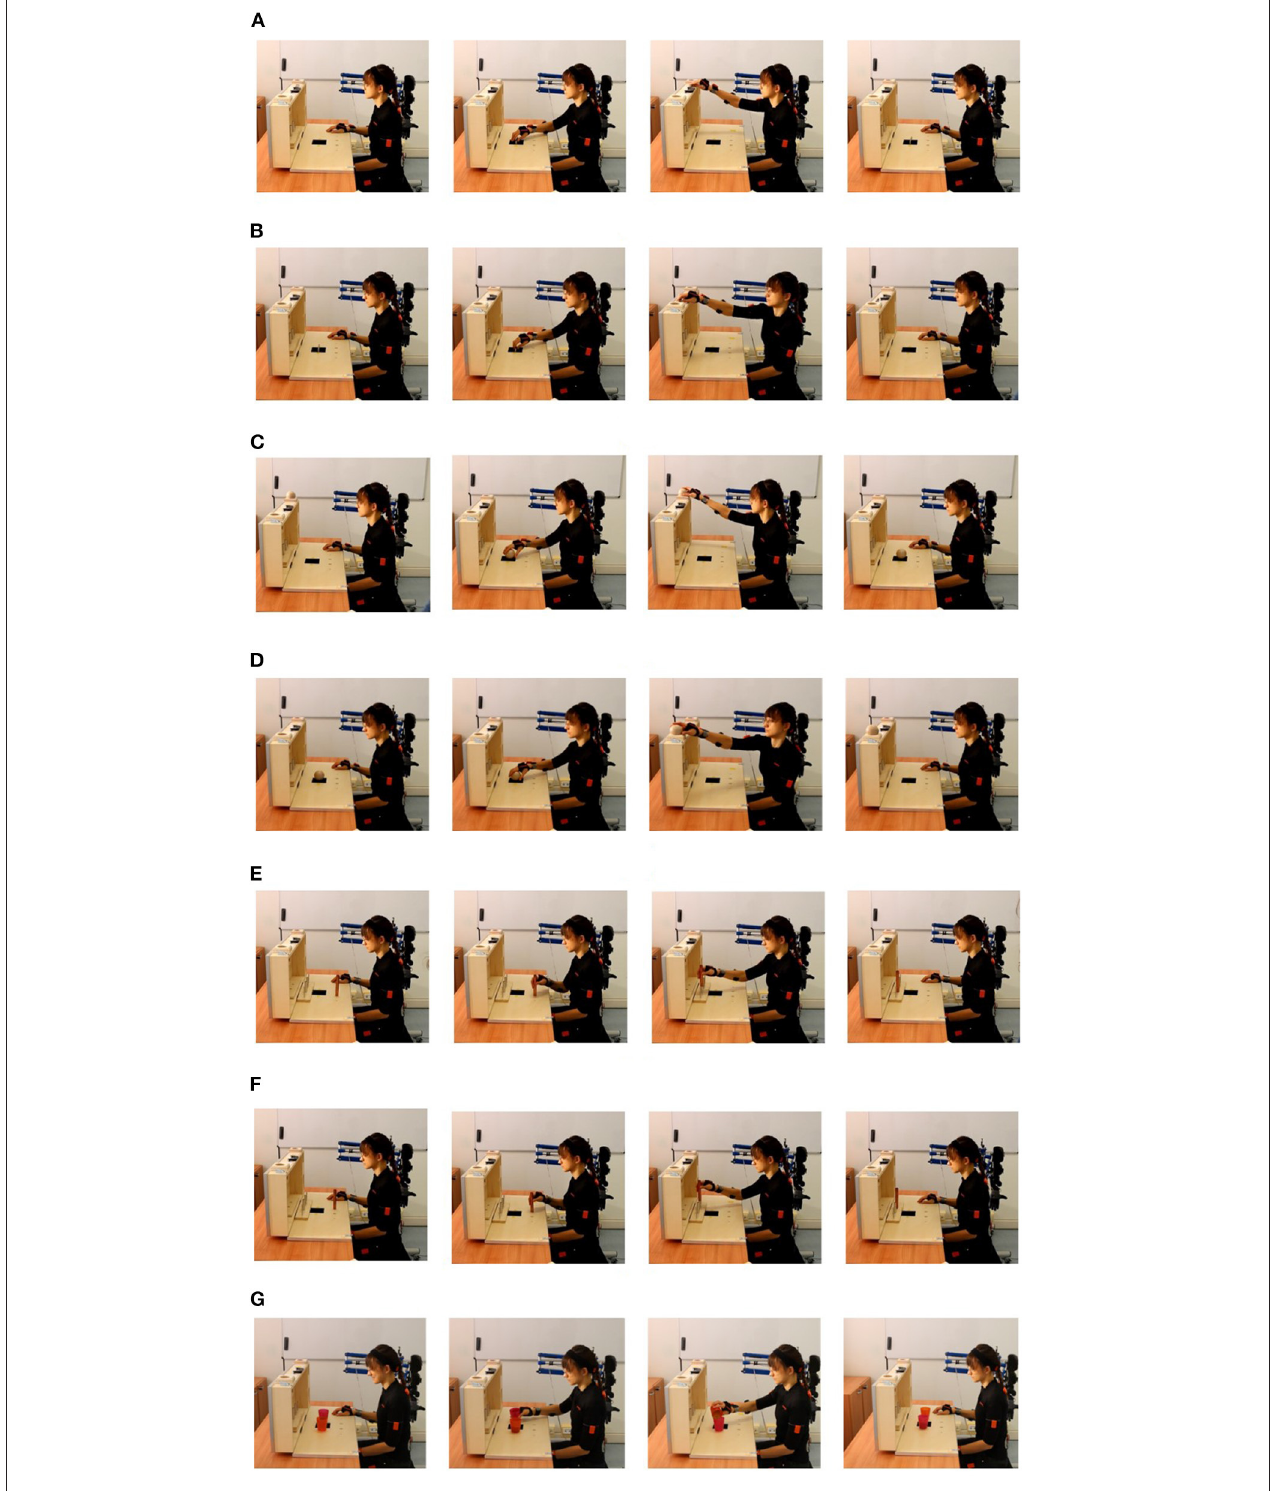
FIGURE 5 | Photo sequences of the tasks. (A) Shows the lifting of the sharpening stone in the ipsilateral side, (B) the lifting of the sharpening stone in the contralateral side, (C) the lifting of the ball in the ipsilateral side, (D) the lifting of the ball in the contralateral side, (E) the moving of the tube in the ipsilateral side, (F) the moving of the tube in the contralateral side, and (G) the pouring of the content of a glass into another.